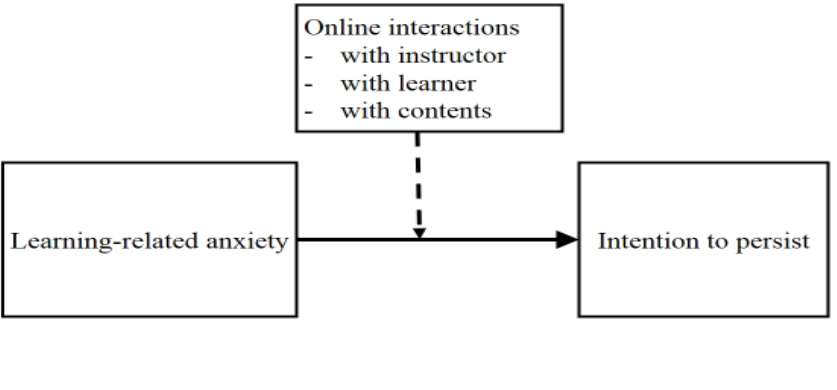
Figure 1. The research